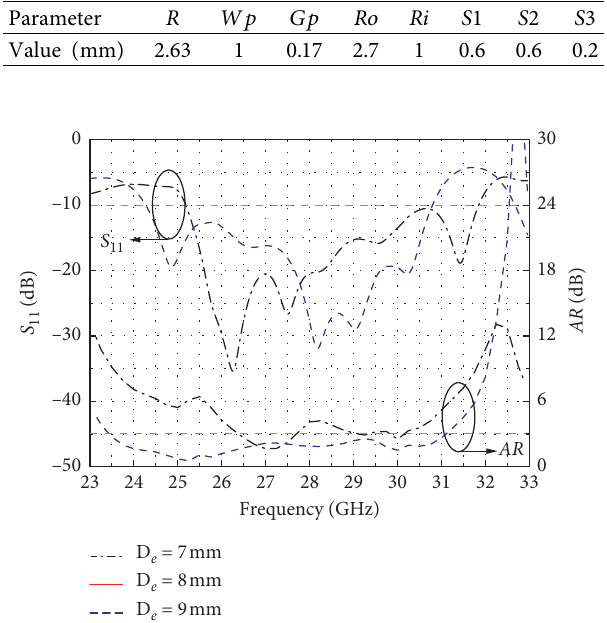
Figure 3: Variations of S